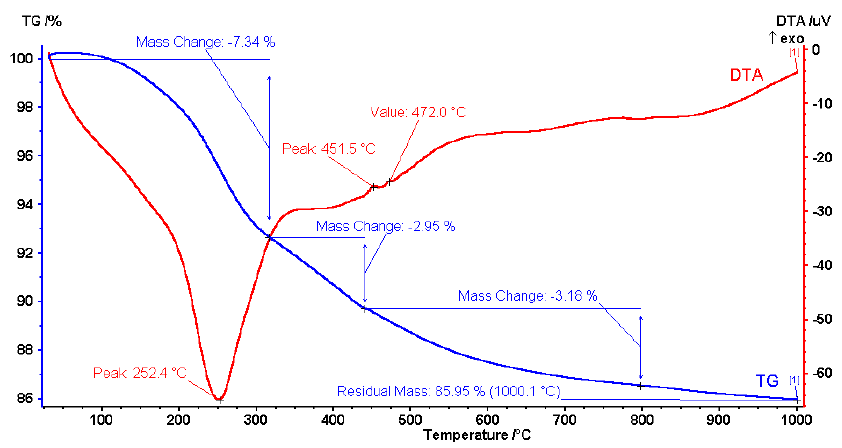
Fig. 2 TG and DTA curves of reaction mixture for Al 0 . 5 La 0 . 5 P 3 O 9 sample (mass: 321